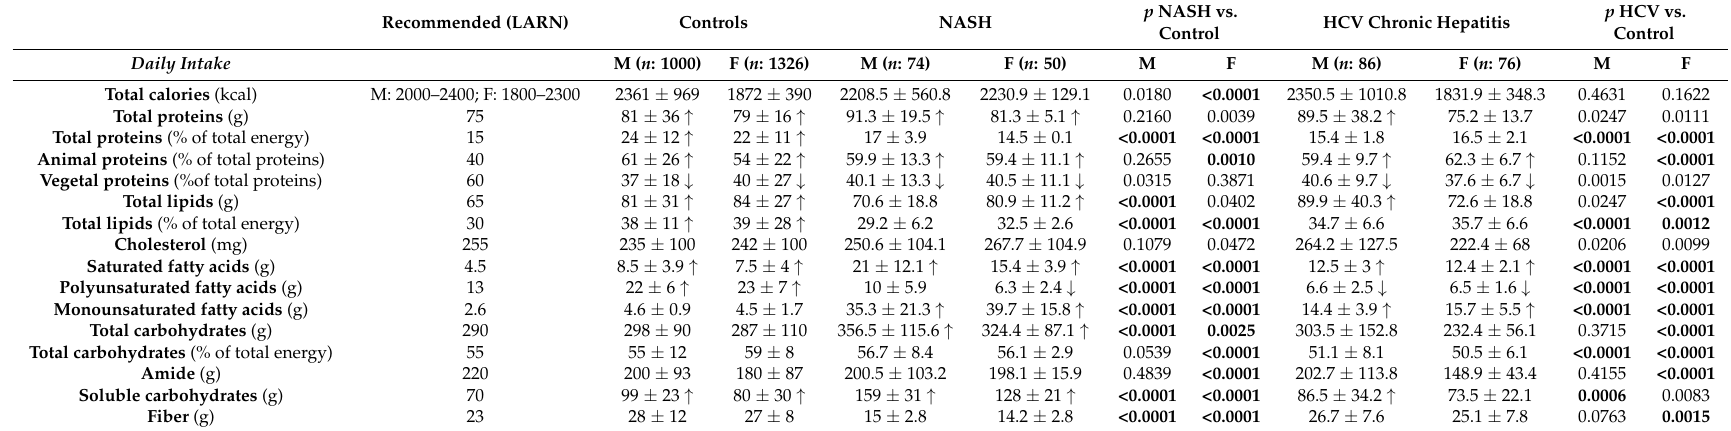
Table 4. Intake of macronutrients in study population ( ↓↑ indicate variations in respect to amounts recommended in Italy) (Males = M versus Females = F; Mean ± Standard Deviation).